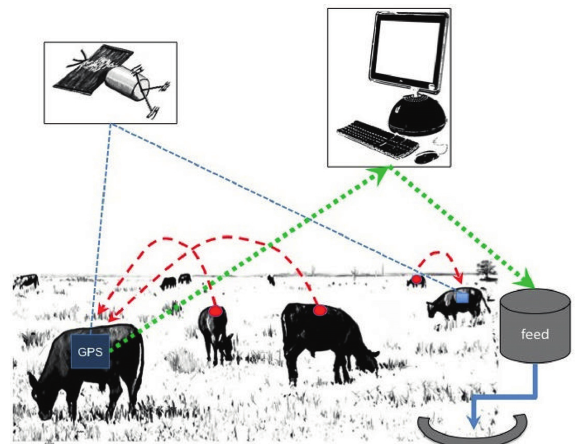
Figure 3: Schematic of a precision grazing system (Laca et al. 2009)